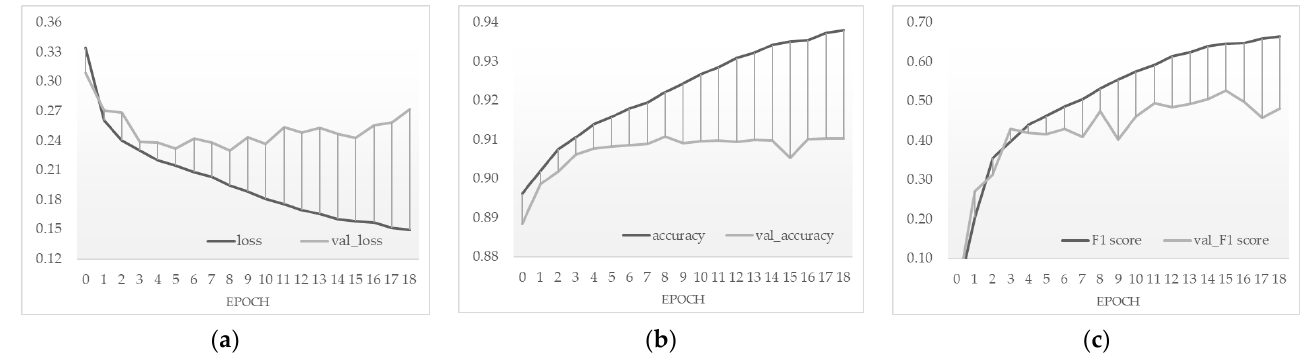
Figure 4. Performance of customised U-Net: ( a ) loss , ( b ) accuracy , and ( c ) F1 score for our fine-tuned model.